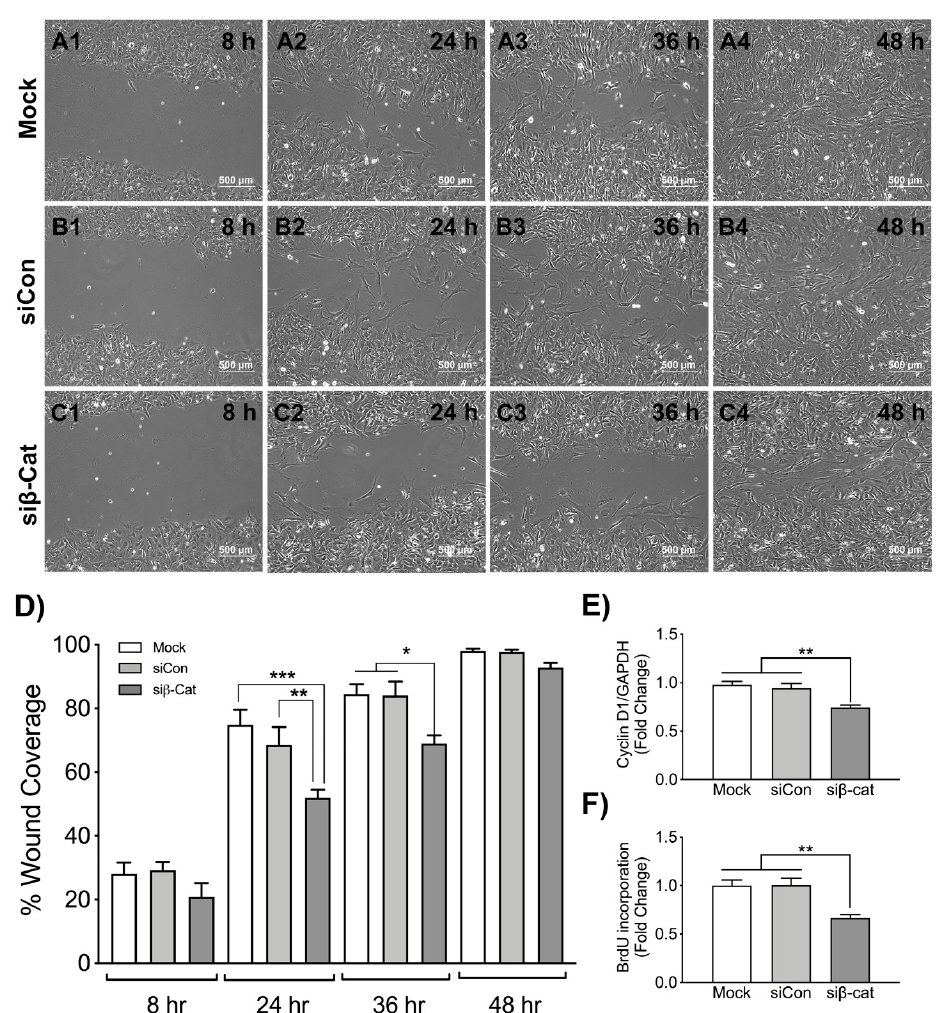
Figure 3. Wound healing and cell proliferation following injury in si β -catenin transfected astrocytes. Astrocytes were transfected with either no siRNA (Mock, white bars), non-targeting siRNA (siCon, light grey bars) or siRNA specific for β -catenin (si β -cat, dark grey bars). Post recovery astrocyte monolayers were scratched with a sterile 10 µL pipette tip, and migration of ( A1 – A4 ) mock, ( B1 – B4 ) siCon, and ( C1 – C4 ) si β -cat transfected astrocytes to the wound site was monitored for 48 h. Phase contrast images captured at 8, 24, 36 and 48 h were shown. Data are representative of three individual donors. Quantified wound healing assay data ( D ) represent an average remaining wound area ± SEM